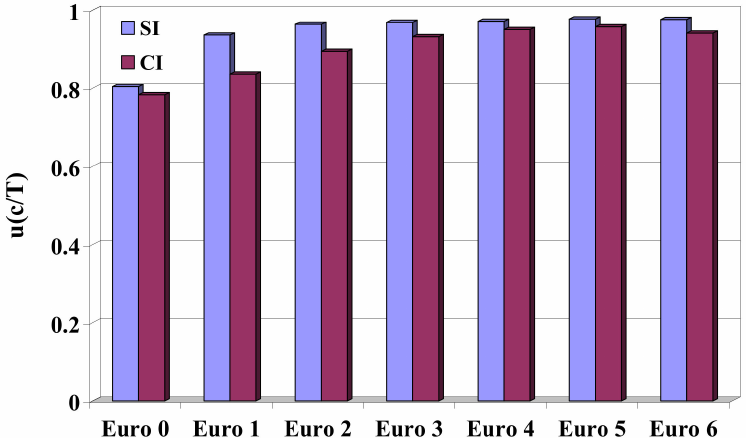
Figure 17. Share of additional carbon oxide emission in total emission—u(c/T), from passenger cars of emission categories Euro 0–Euro 6 during warm-up of spark-ignition engines—SI and pollutant compression-ignition engines—CI, under model vehicle traffic conditions.